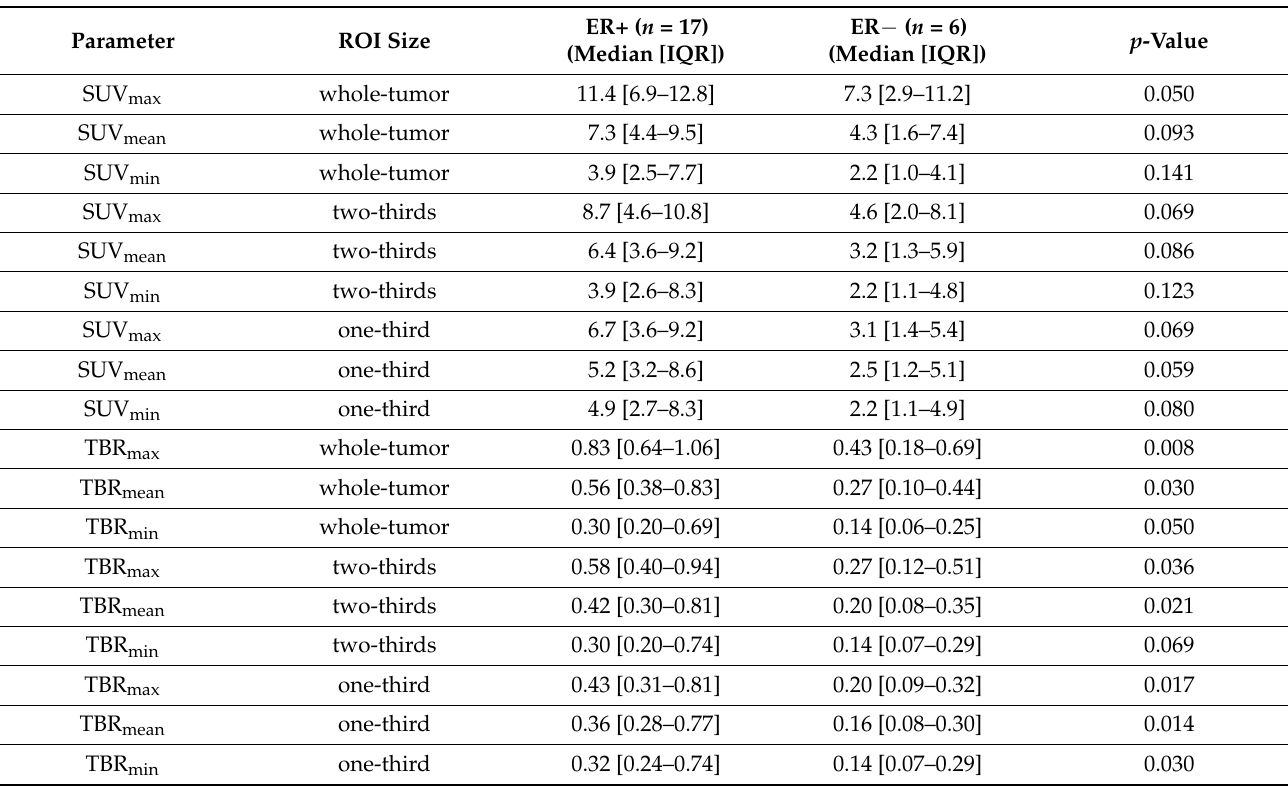
Table A1. [ 18 F]-FES uptake in liver metastases per ER status and per PET outcome parameter.